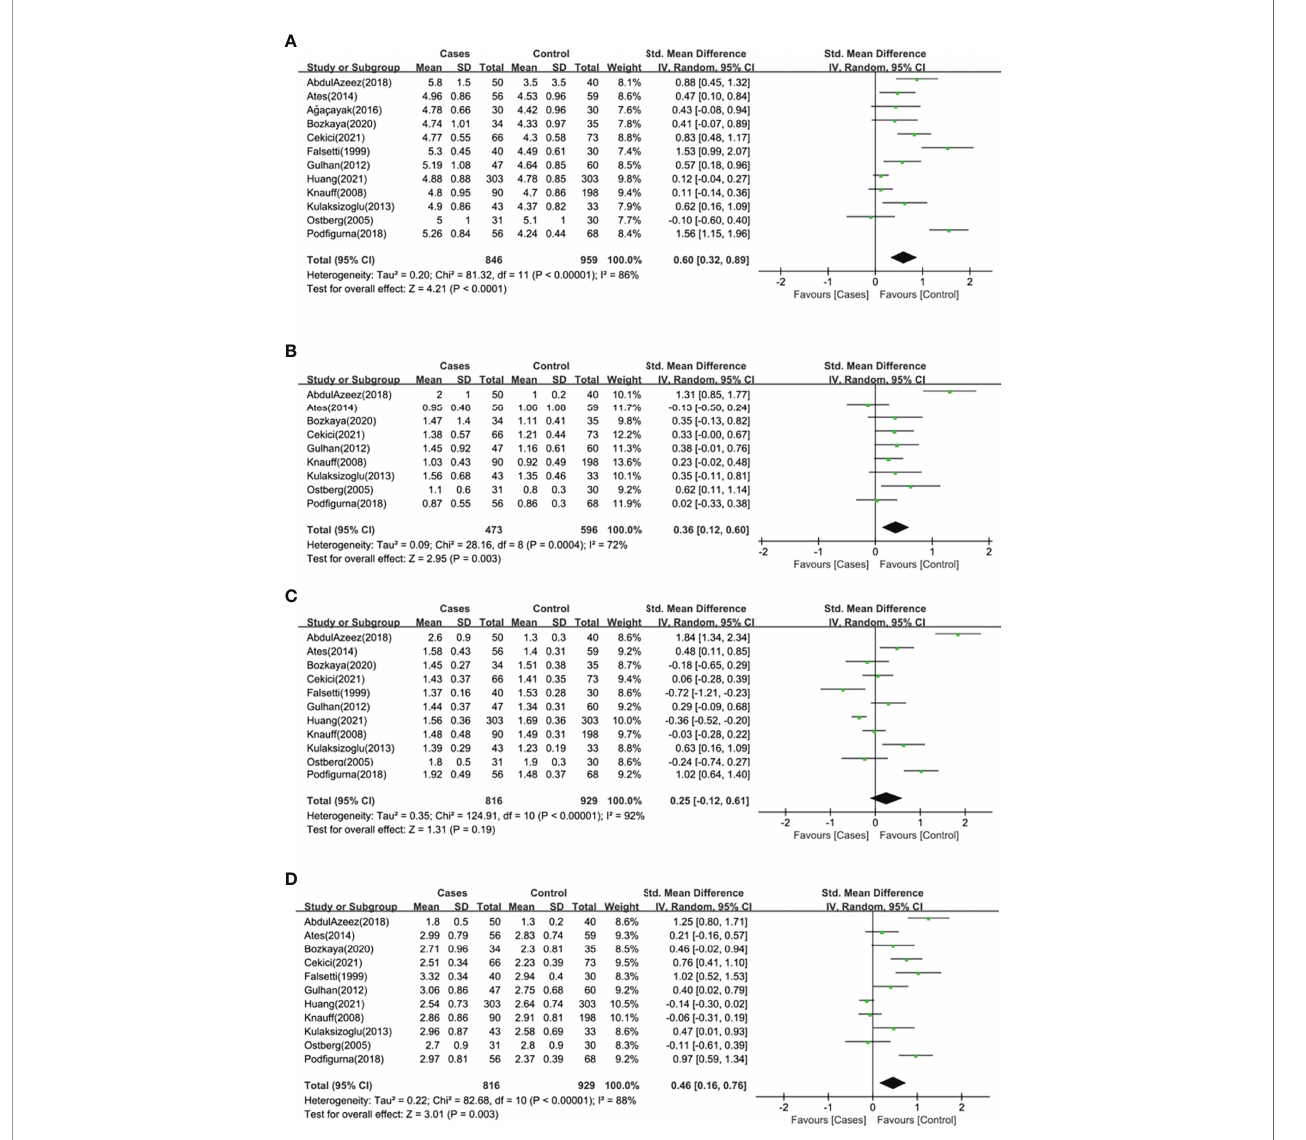
FIGURE 2 | Forest plot of the levels of serum lipid pro fi le in cases and healthy controls. Weights are from random effects analysis. (A) Meta-analysis of total cholesterol. (B) Meta-analysis of triglyceride. (C) Meta-analysis of high density lipoprotein. (D) Meta-analysis of low density lipoprotein. CI, con fi dence interval; SD, standard